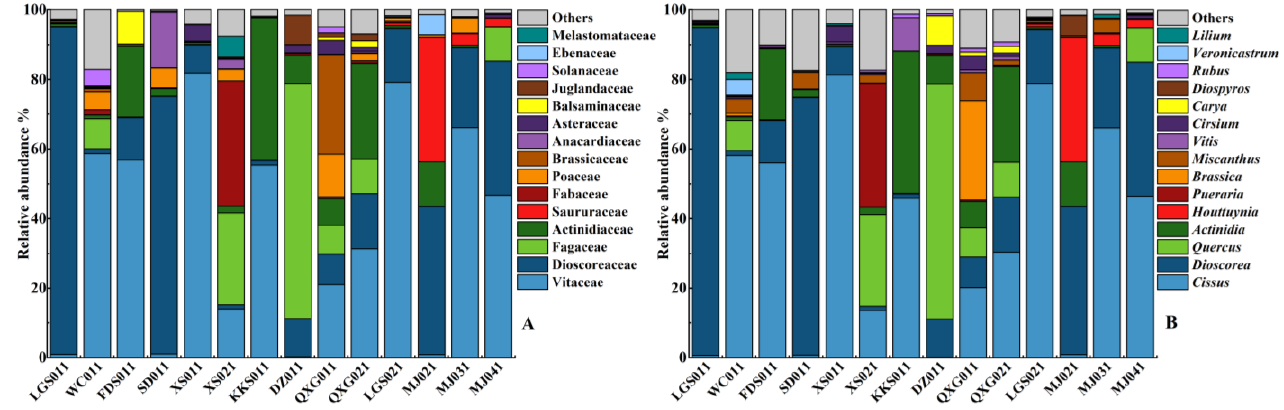
Figure 2. Relative plant food source abundance for wild boars at the ( A ) family level and ( B ) genus level.